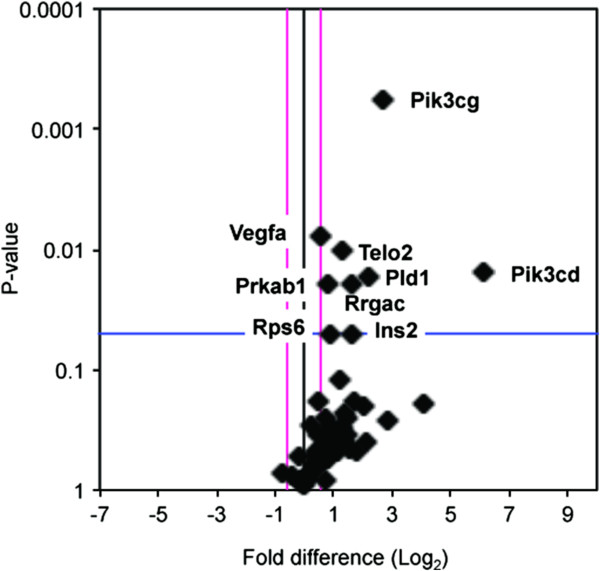
The log2 fold changes in gene expression between high producer (CL47[1]) and low producer (160[6]) lines against t-test P-values. Vertical line represents the threshold of fold changes (i.e., 1.5); horizontal line represents the significant difference of t-test P-values (i.e., 0.05). Significantly expressed genes (P-values < 0.05) are tabulated in Table 2.